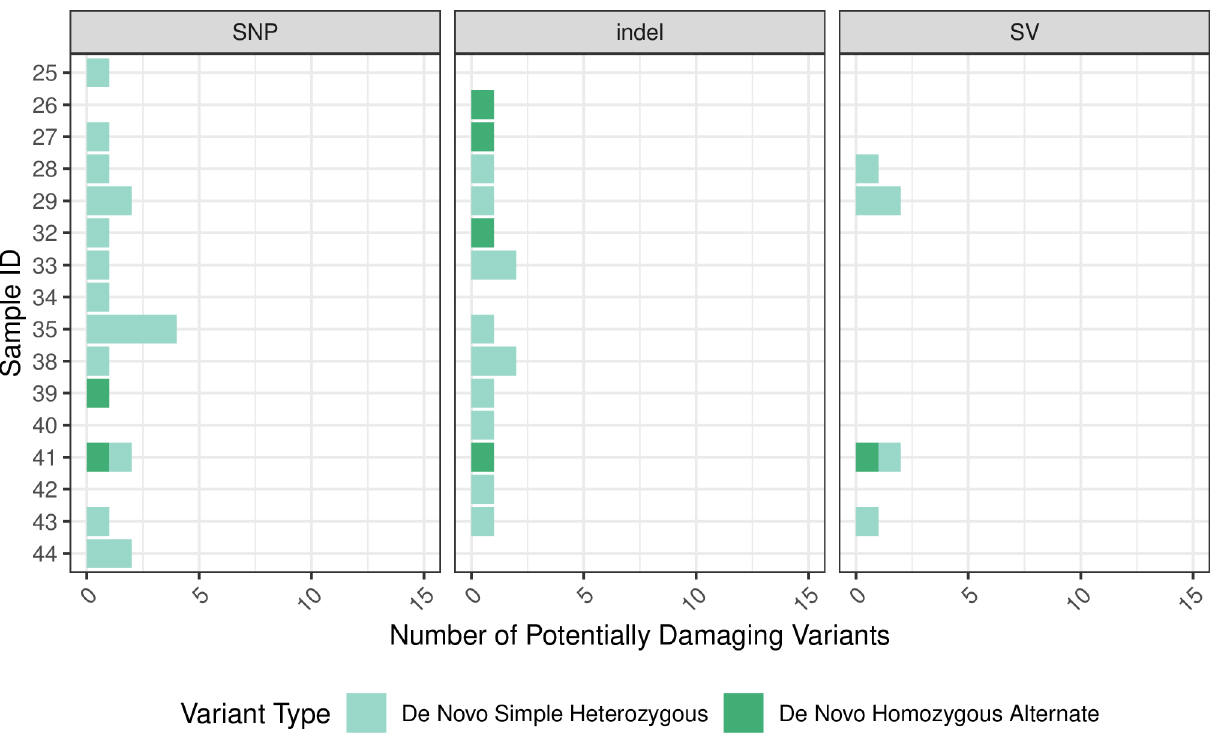
Fig 4. Summary of de novo variants. This figure shows the number of variants that were de novo for each variant category for each